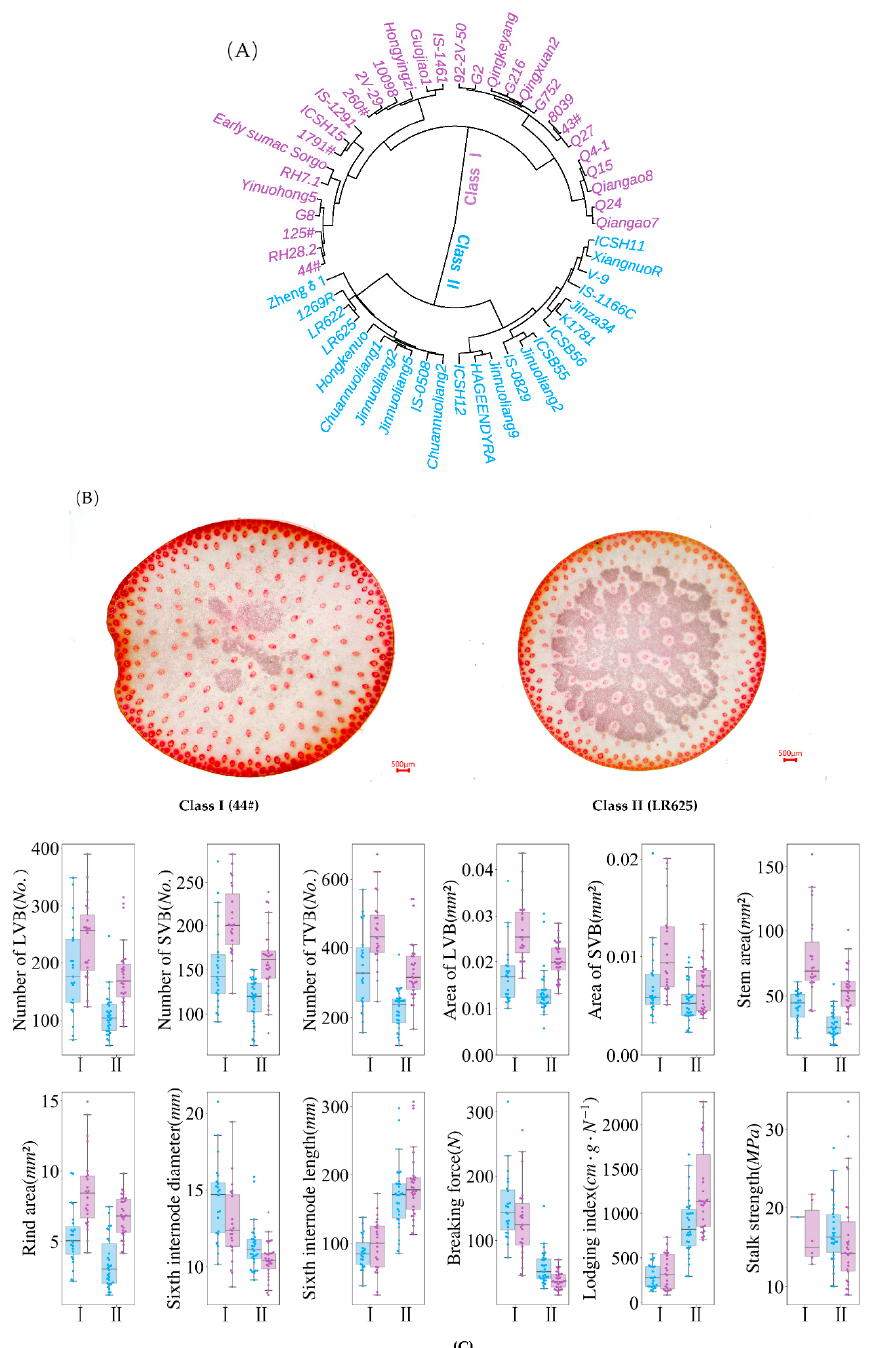
Figure 4. The differences in two classes of sorghum resources: ( A ) clustering analysis of sorghum resources (pooled data of two seasons); ( B ) anatomical sections of the two representative genotypes from class I (left) and class II (right); ( C ) box-plots to illustrate the differences between class I and class II (season 1 is in blue, season 2 is in purple).